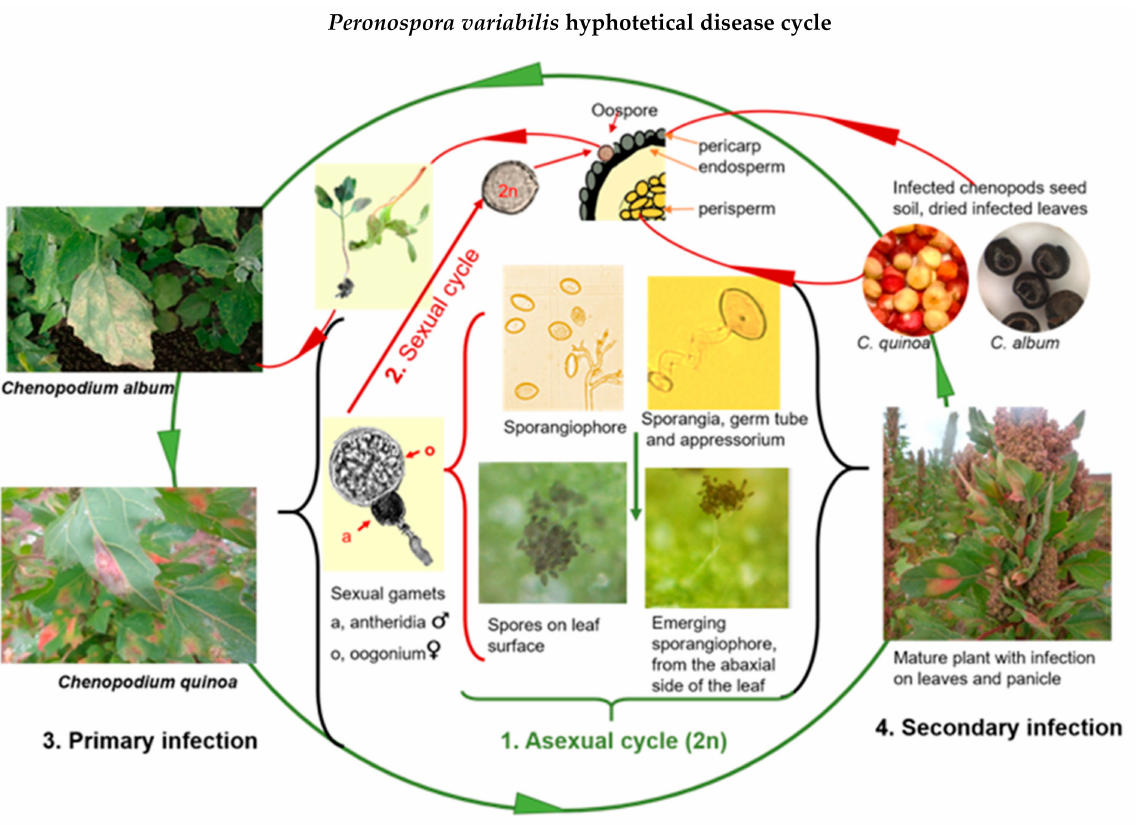
Figure 2. Proposed disease cycle of quinoa downy mildew caused by Peronospora variabilis (Photos: C. Colque-Little). Picture of haploid gamets adapted from Judelson